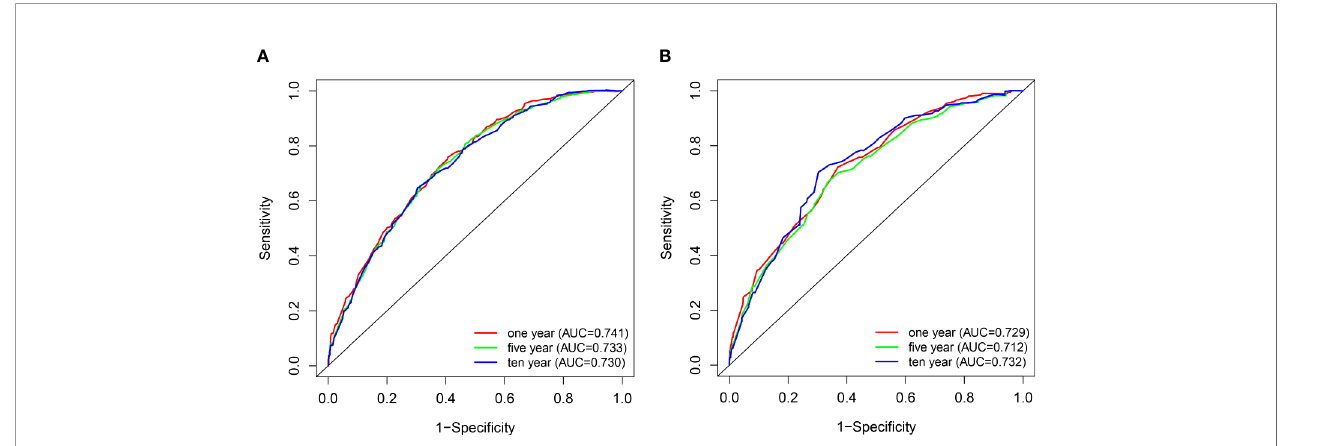
FIGURE 4 | ROC curves of the nomogram for 1-, 5-, and 10-year CSS prediction in the training cohort (A) and validation cohort (B)